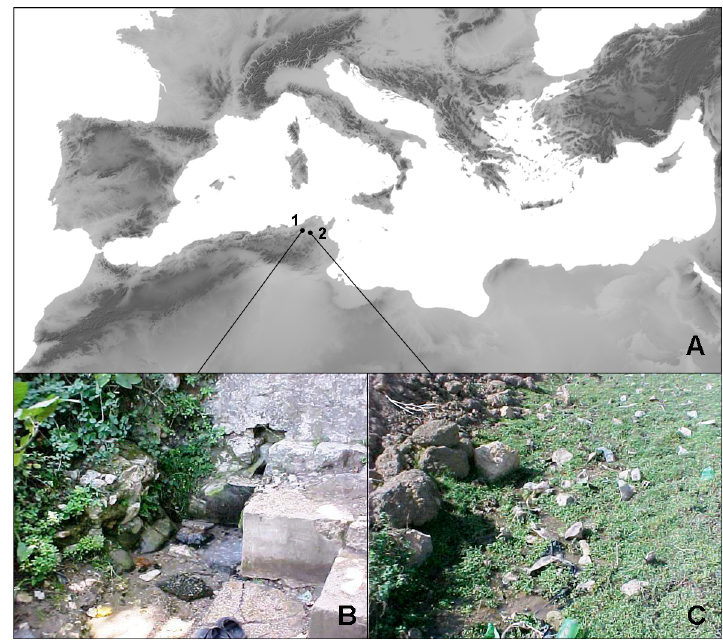
Fig. 1 . Map and photographs of the studied sampling sites. A . Map showing the geographic distribution of Bullaregia tunisiensis sp. nov. B . Aïn Gnaa (Bulla-régia, Jendouba). C . Djebba (Thibar,